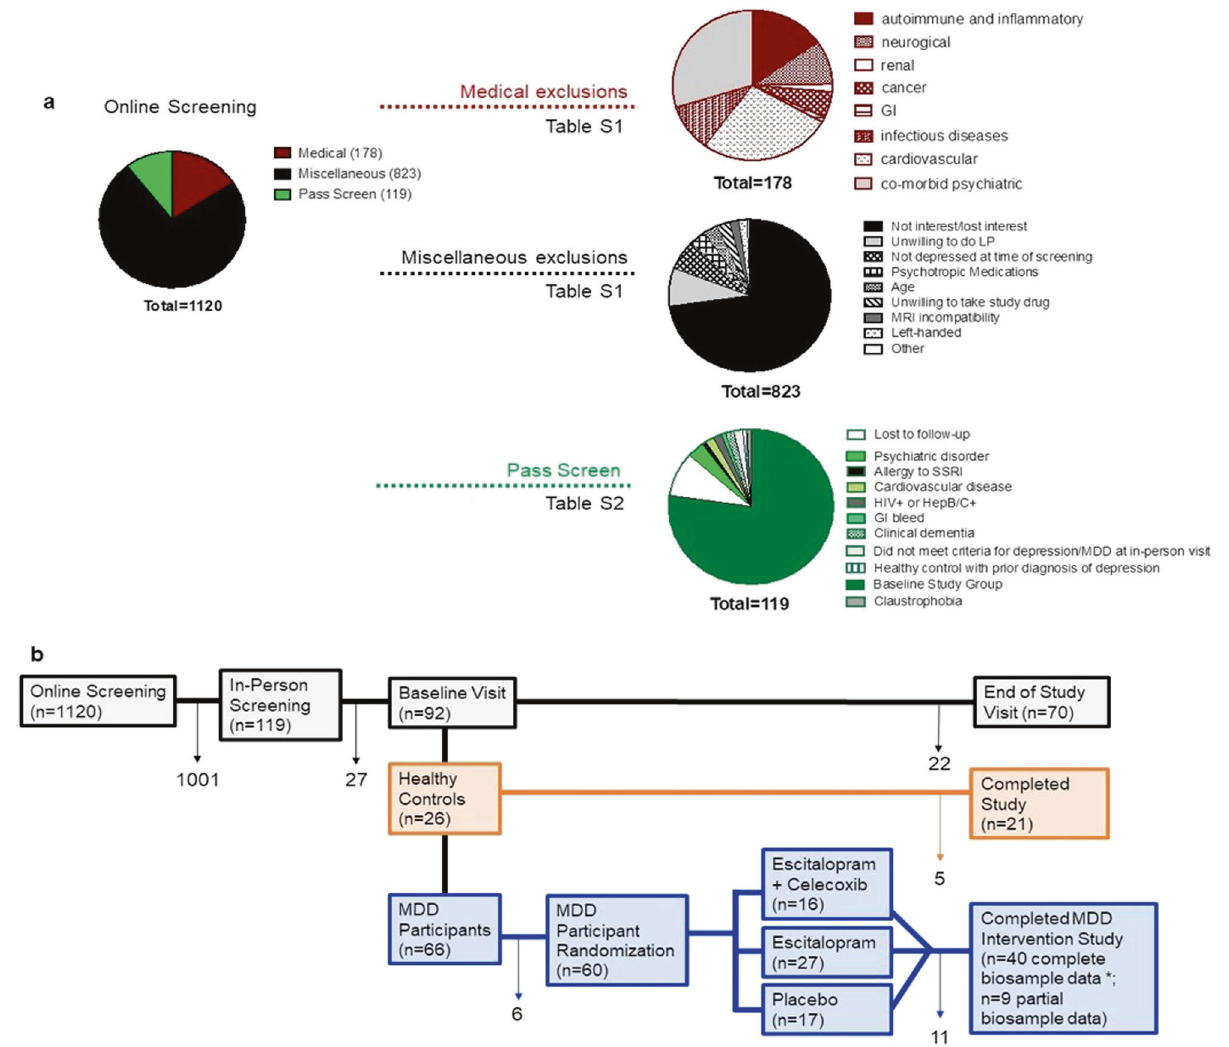
Fig. 1 Overview of study participant groups, screening, and cohorts. a 1120 individuals were screened online. Of those, 178 were excluded for medical reasons (red chart and see Table S1 for further details) and 823 were excluded for miscellaneous reasons (black chart and see Table S1 for further details). The remaining 119 individuals passed the screen (green). Of those, additional individuals withdrew or were excluded upon further review (see Table S2 for details). b Numbers of individuals for screening, baseline, and randomization visits as well as the fi nal subject numbers. Arrows indicate the number of individuals who withdrew or were excluded at various stages of the study. MDD = major depressive disorder. Of the n = 49 who completed the study * n = have complete biosample data sets. Of these 40, n = 18 escitalopram, n = 12 escitalopram + celecoxib, n = 10